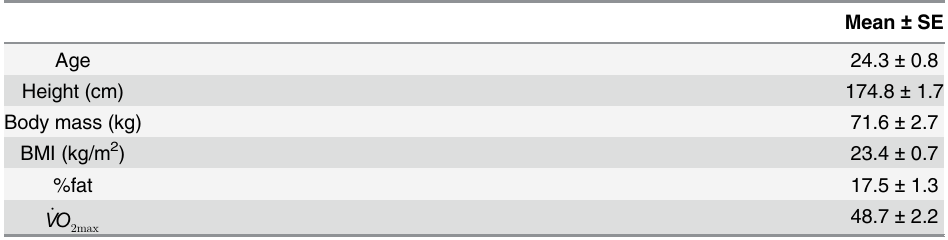
Table 1. Baseline physical characteristics (N =